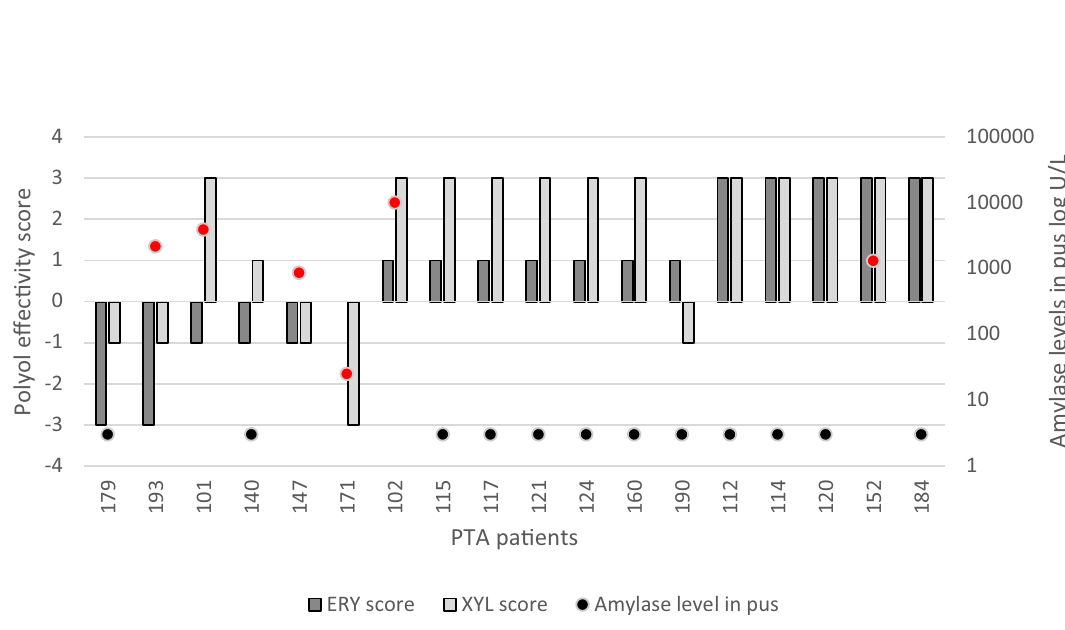
Figure 5. Amylase levels in PTA pus (red dots—high level, black dots—low level) and polyol effectivity score (PES) against S. pyogenes isolates from PTA pus. PES was calculated as a summary effect of three polyol concentrations (2.5%, 5% and 10%), where each polyol concentration contributed − 1, 0 or + 1 points depending on whether the S. pyogenes growth increased, remained unchanged or decreased in the presence of the polyols,